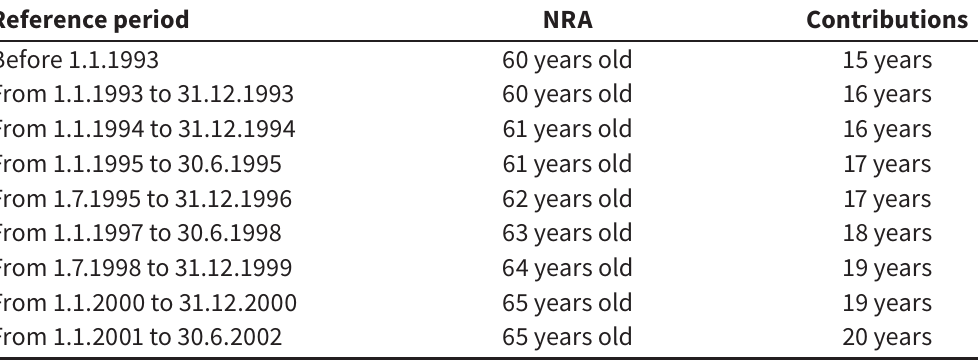
Eligibility conditions required for old-age pension as established by the 1992 Pension Reform (male private sector